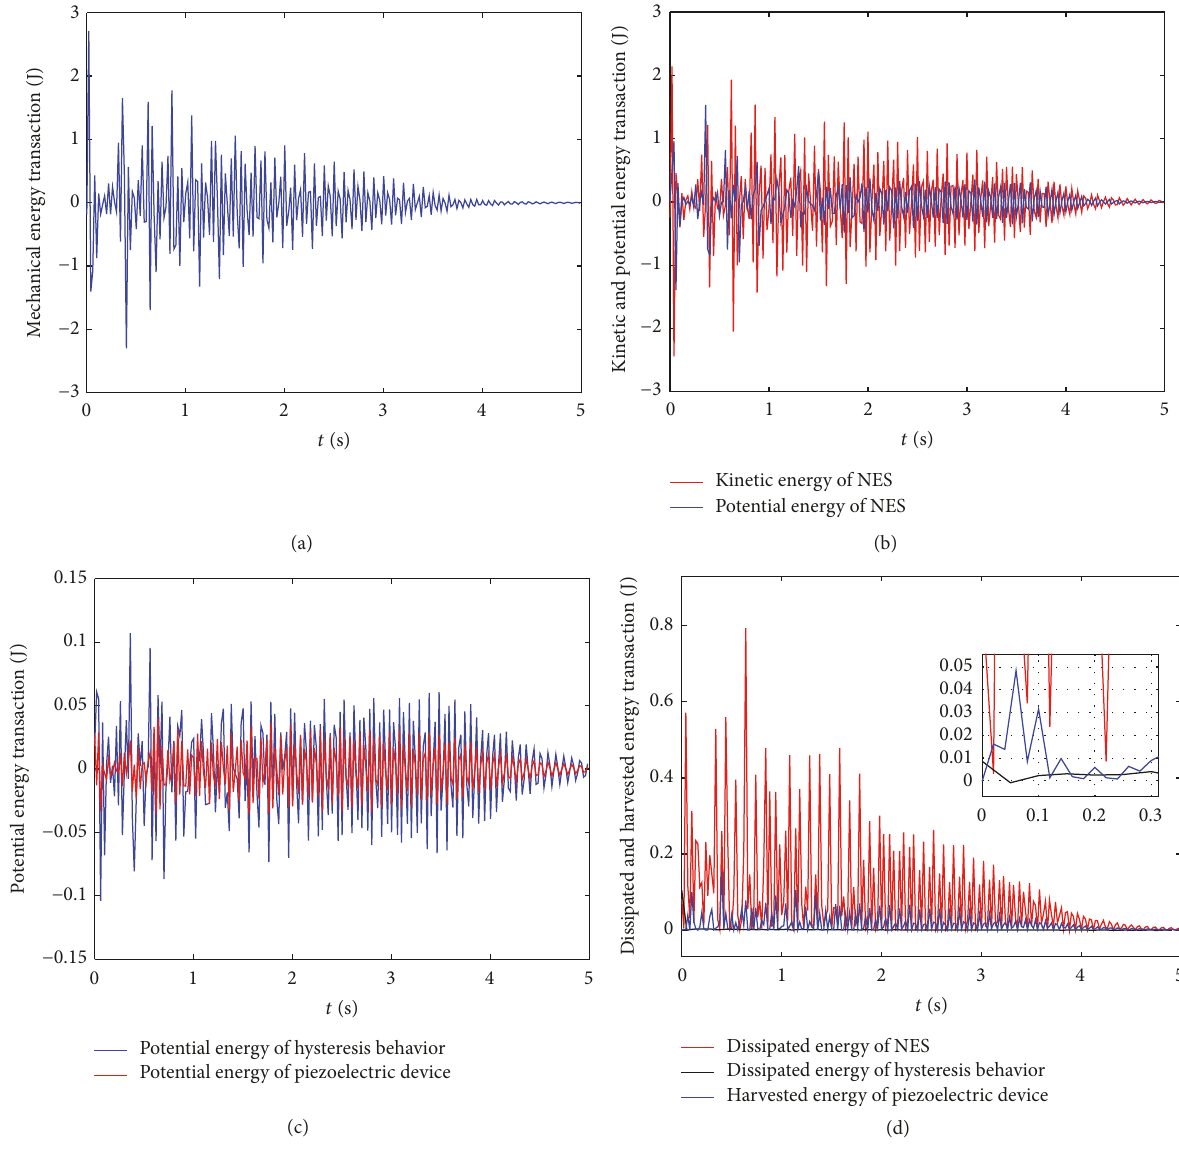
Figure 8: Configuration 1: (a) mechanical energy transaction in the NES-piezoelectricity system; (b) kinetic and potential energy transaction of NES; (c) potential energy transaction of hysteresis behavior and piezoelectric device; (d) dissipated and harvested energy transaction in the NES-piezoelectricity